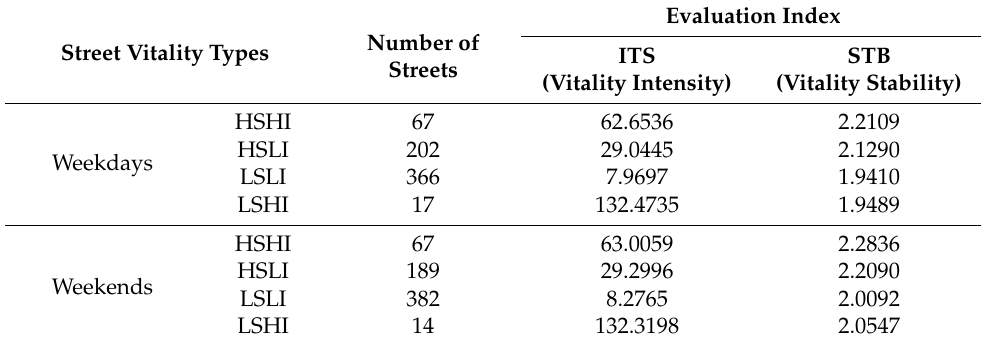
Table 2. Classification and evaluation of street vitality types.